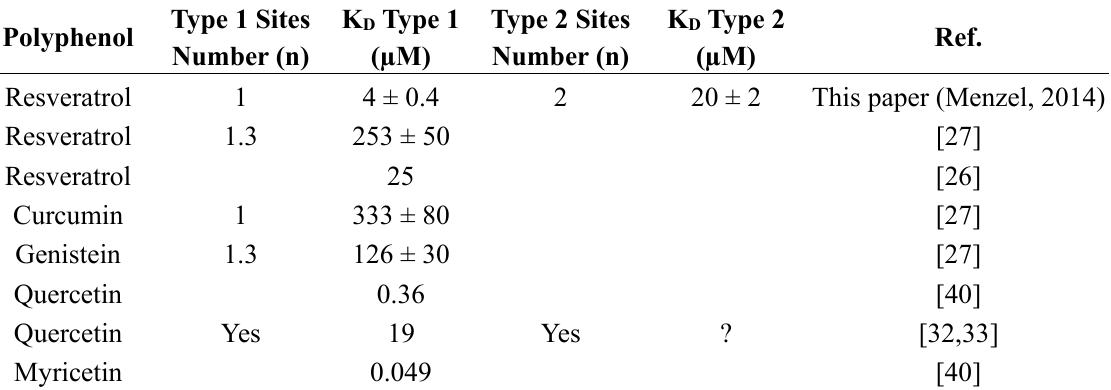
Table 2. Comparison of binding site number and binding constants of dietary polyphenols to plasmatic